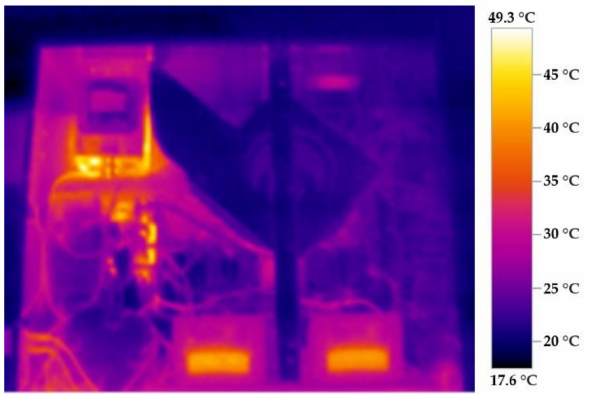
Figure 7. Thermal diagram of heated components of the microwave power generator after 10 min of full power.